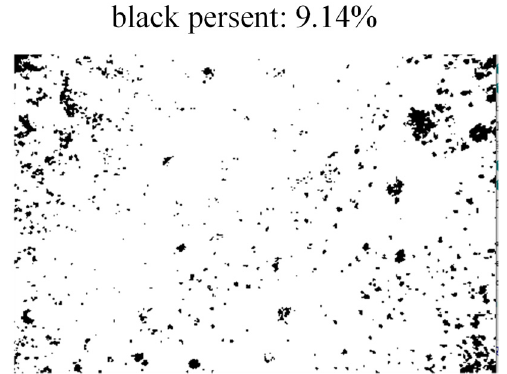
Figure 8. Binarized images with 28 W.